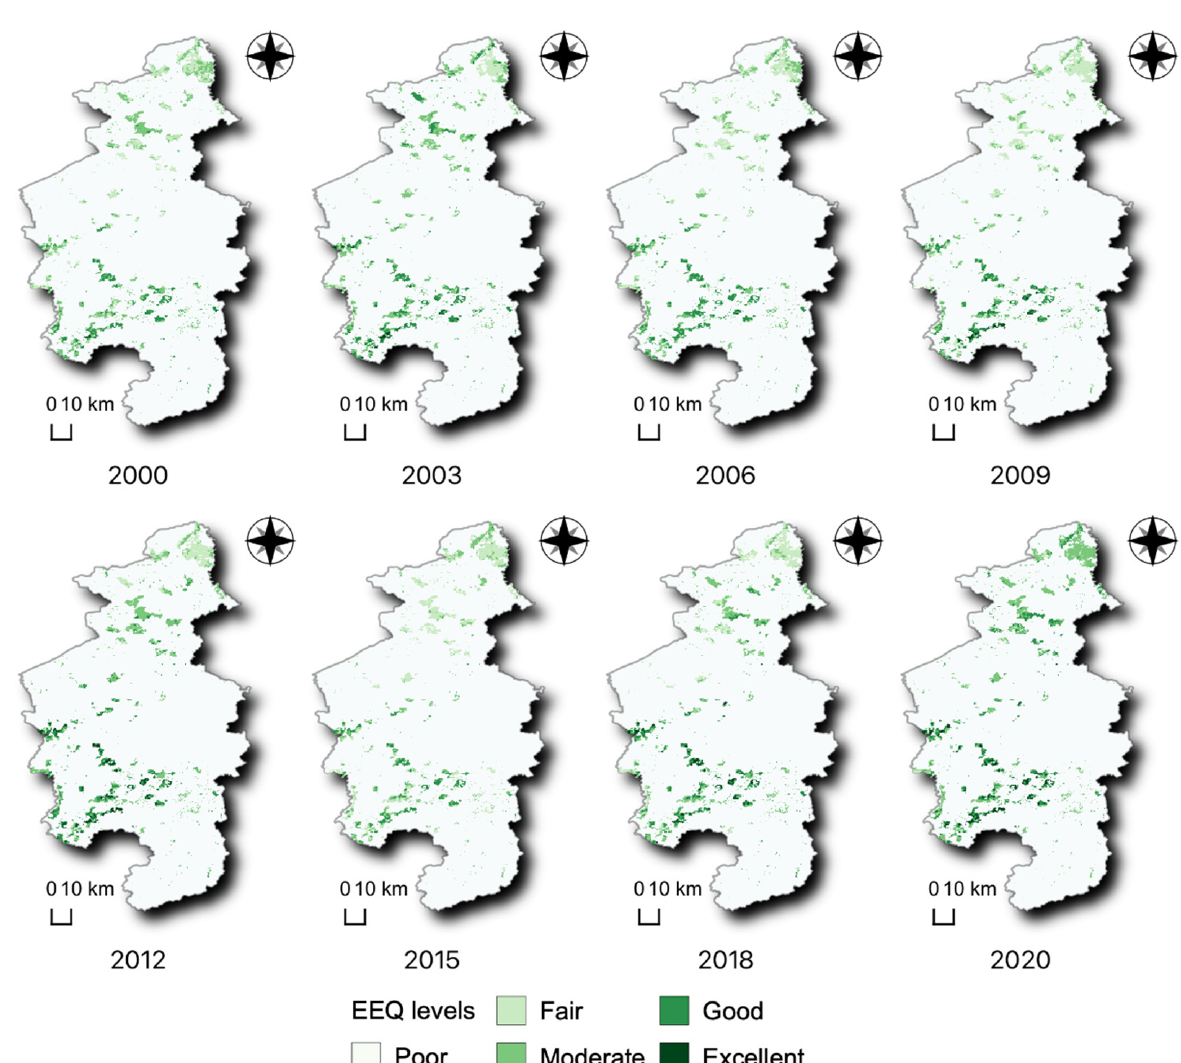
Figure 5. Spatial distribution of EEQ levels, same as before, in the FC areas in selected years from 2000 to 2020.